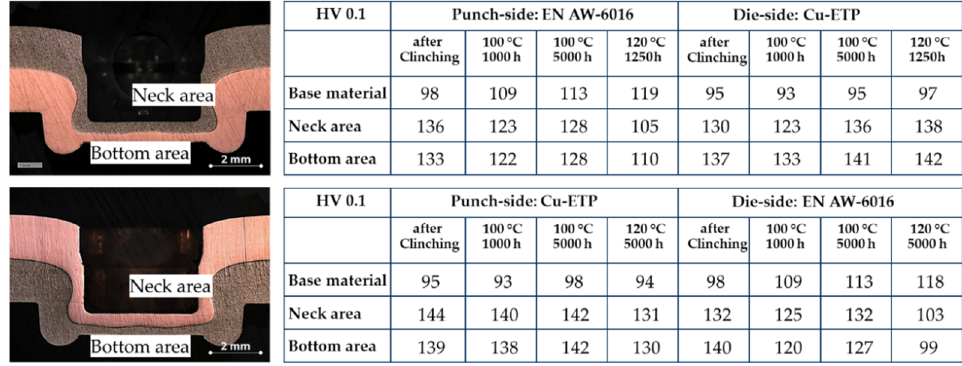
Figure 13. Hardness measurement in areas of maximum forming joining combination Cu-ETP, s 1 = 2.0 mm/EN AW-6016, s 2 = 2.0 mm each materiel as punch and die side layer according to [5].